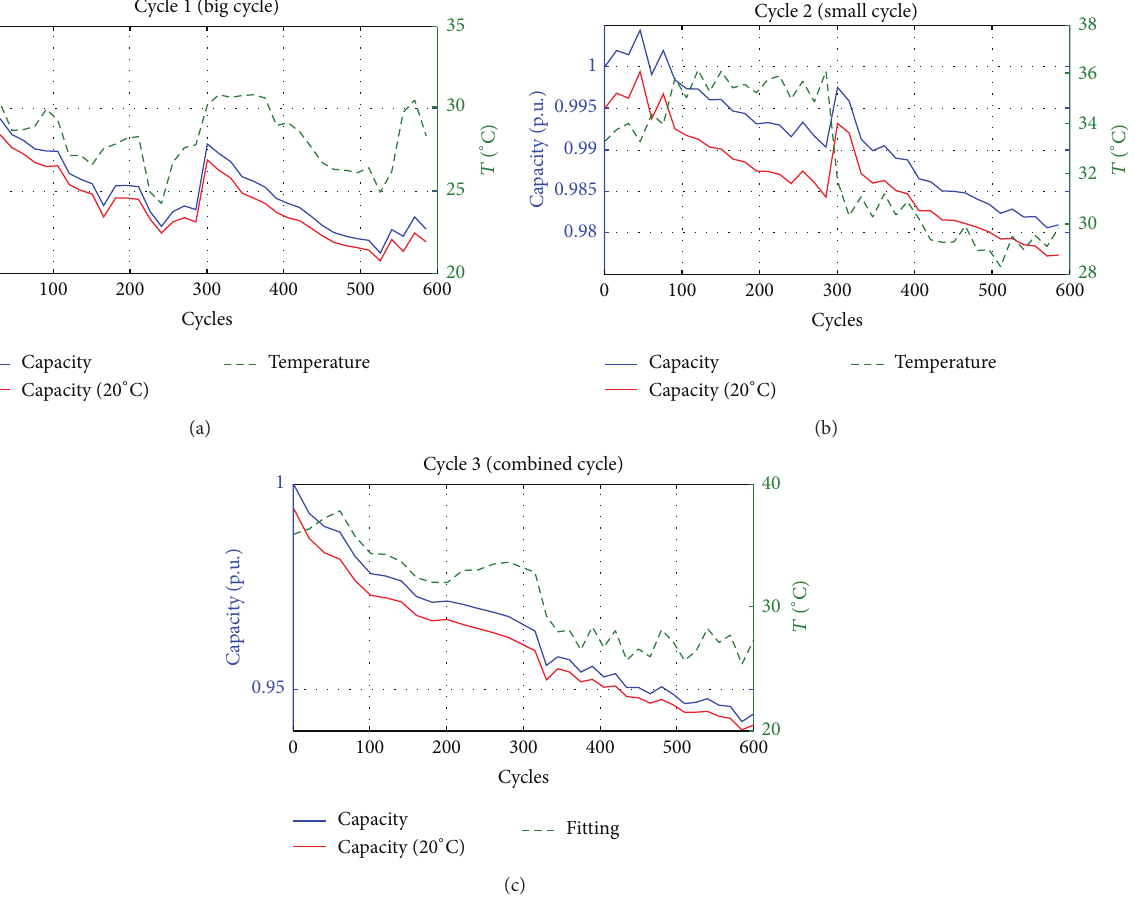
Figure 3: Ageing of the three cells as function of the cycles.